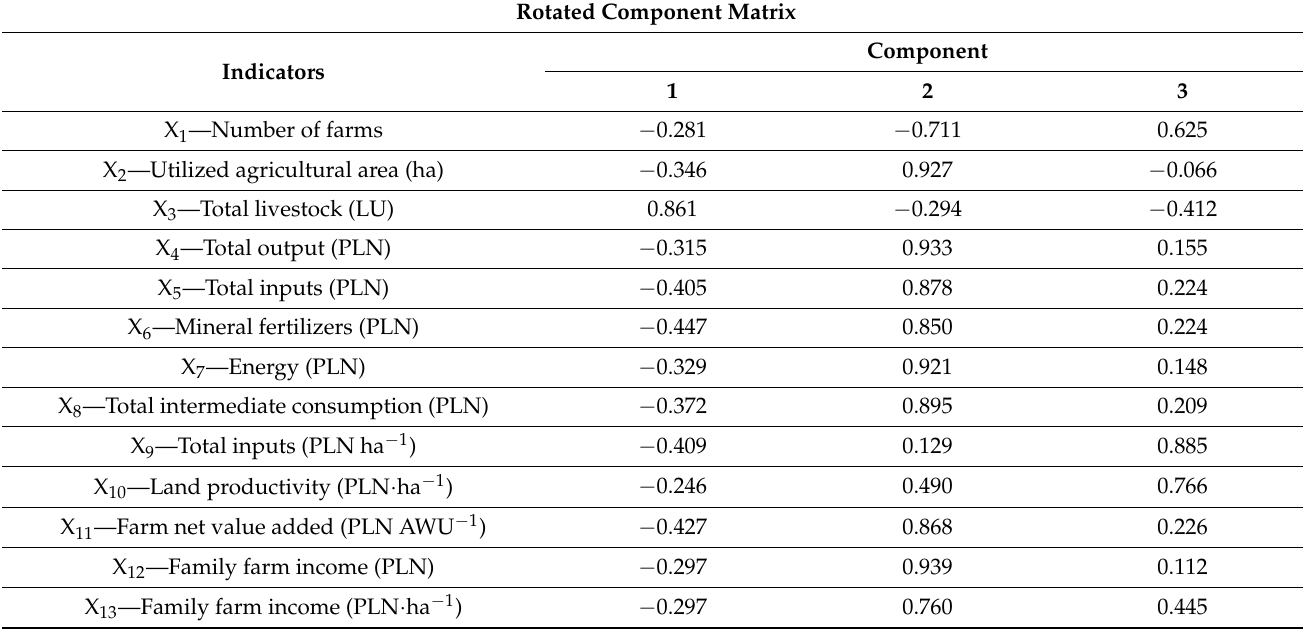
Table A4. Eigenvalues and proportions of total variance in 15 years as explained by the first three principal components for original traits and correlation coefficients between these traits and the first three PCs on field crop